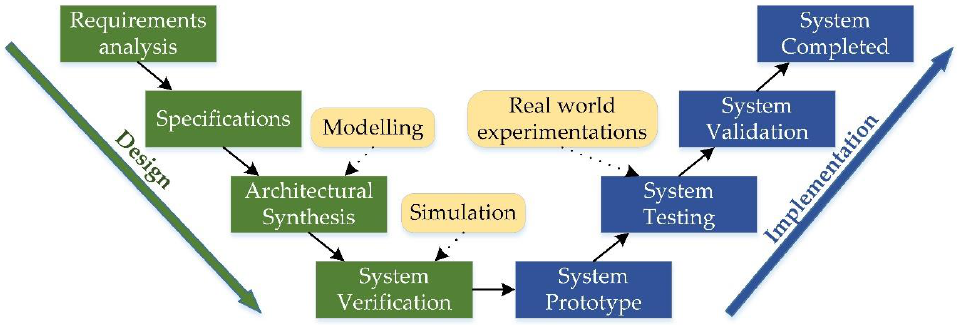
Figure 3. Traditional development process.